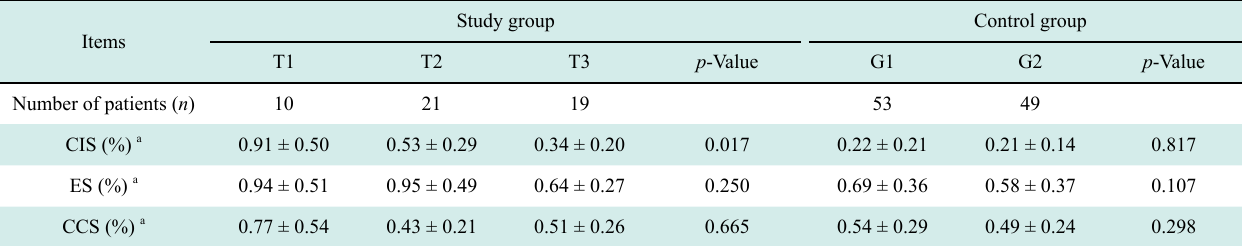
Table3. Data refined in the study group and in the control group